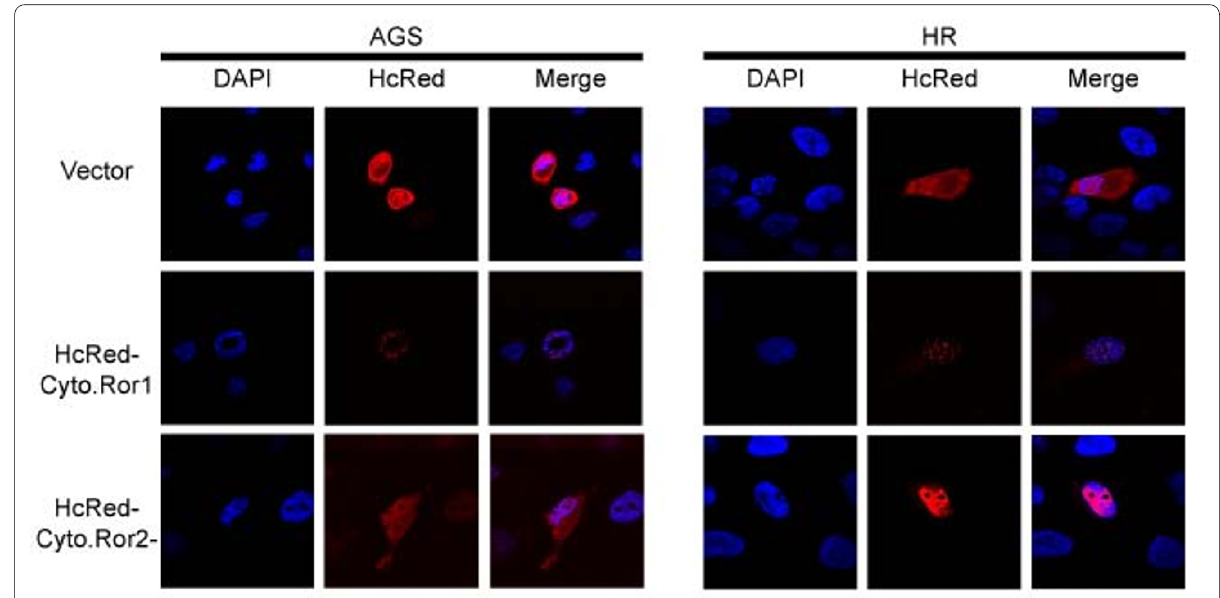
Figure 1 Ror1/2 mutant with the truncation of the ligand-binding and transmembrane domains are capable of nuclear transport . AGS and HR cells were transfected with the cytoplasmic part of Ror1/2 whose N-terminal was HcRed-tagged or with a vector control, and then analyzed by fluorescence confocal microscopy. The protein size of HcRed only is about 30 kDa; and the size of the HcRed-tagged Ror1/2 is about 85